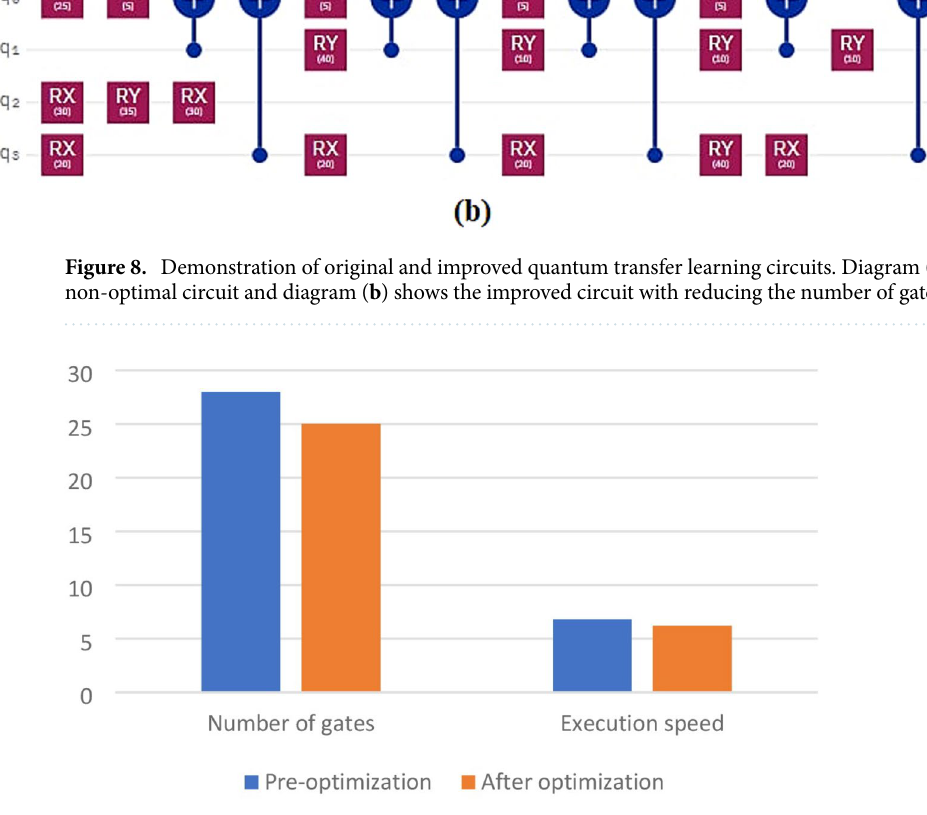
Figure 9. Demonstration of optimized and non-optimized diagrams of quantum transfer learning circuits.